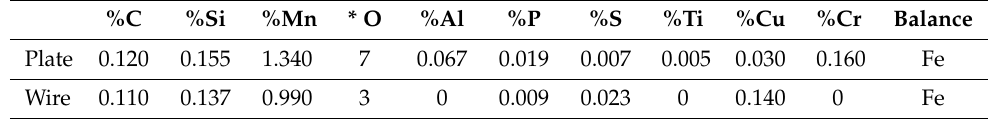
Table 1. Composition of steel base plate and weld wire used in welding tests (mass%) [24].